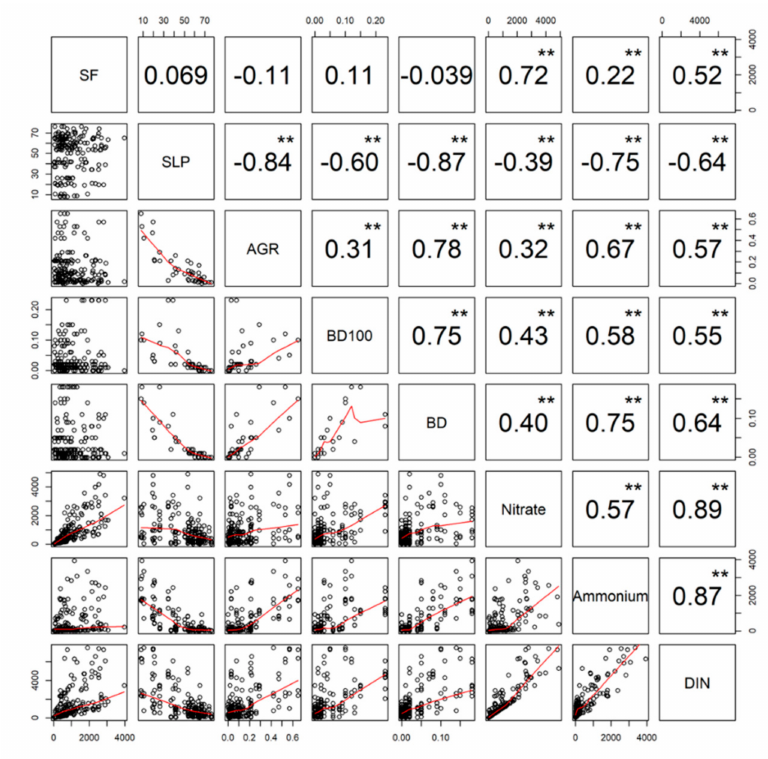
Figure 5. Scatterplot matrix among relative streamflow [SF; mm], slope at watershed scale [SLP; %], the proportion of agriculture at watershed scale [AGR; %], the proportion of buildup in 100 m bu ff er zone [BD100; %], the proportion of buildup at watershed scale [BD; %], NO 3 − , NH 4 + , and DIN exports based on all sampling sites. The asterisk indicates that the correlation is statistically significant ( p -value: ** < 0.01), and the red lines indicate smooth transition